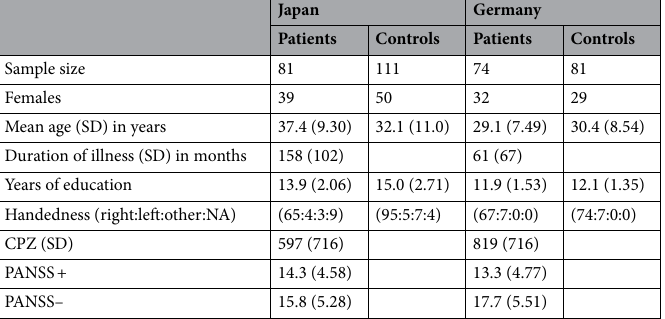
Table 1. Summary of social and clinical data of the two samples. CPZ = chlorpromazine equivalents; PANSS + = Positive and Negative Syndrome Scale, Positive Scale; PANSS-: Positive and Negative Syndrome Scale, Negative